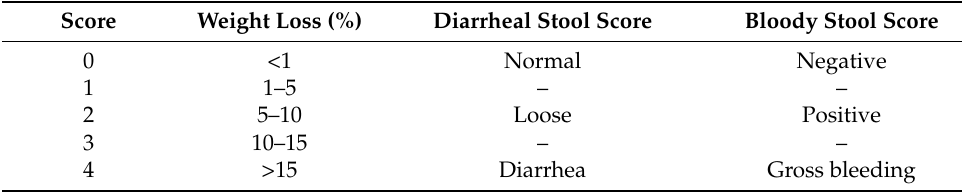
Table 1. Disease activity index (DAI) scoring system.